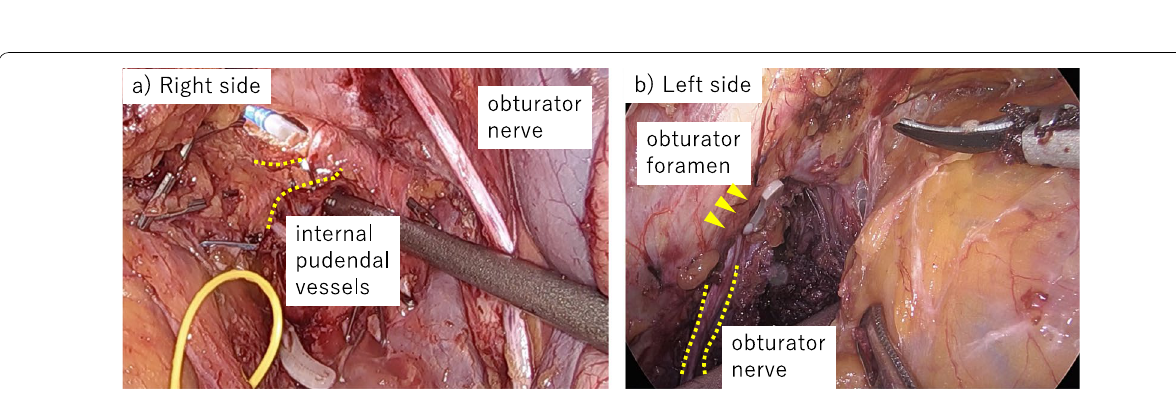
Fig. 3 Laparoscopic view a The rendezvous was performed with the perineal side based on the internal pudendal vessels (yellow dashed line). b The left internus obturator muscle was incised using the obturator nerve (yellow dashed line) and foramen (yellow arrowheads) as